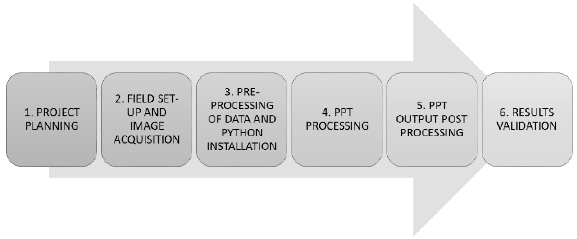
Figure 3. General methodology of the